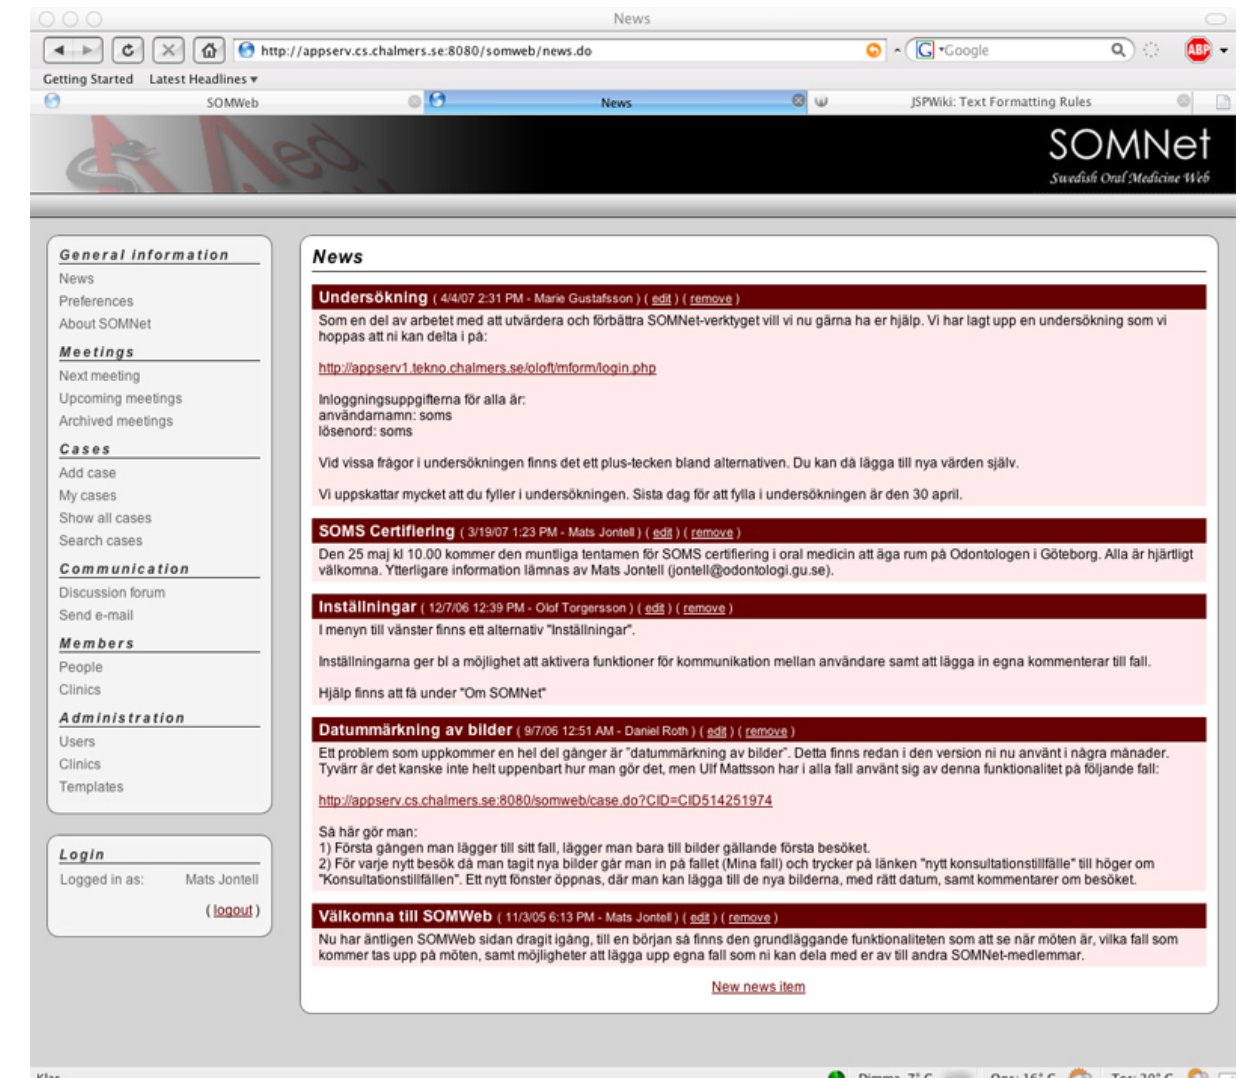
Figure 3. News page with information for all